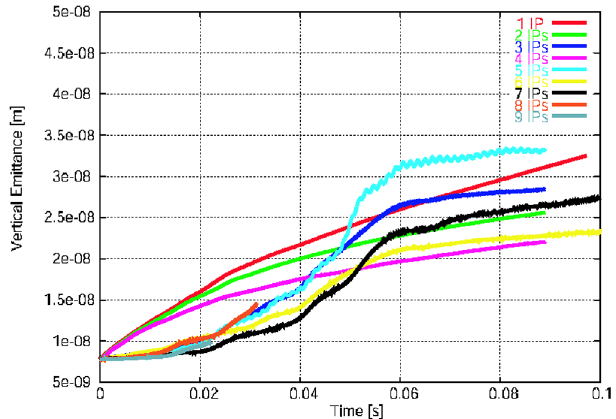
FIG. 51. (Color) Simulated vertical bunch shape (centroid and rms beam size) after 0, 250, and 500 turns in the CERN SPS assuming a cloud density of 10 12 m (cid:2) 3 with proton space charge at 26 GeV =c [53]; the HEADTAIL code was used; the vertical scale extends from (cid:2) 8 to (cid:10) 8 mm , the horizontal axis from (cid:2) 0 : 6 ). to (cid:10) 0 : 6 m ( (cid:6) 2 (cid:16) z